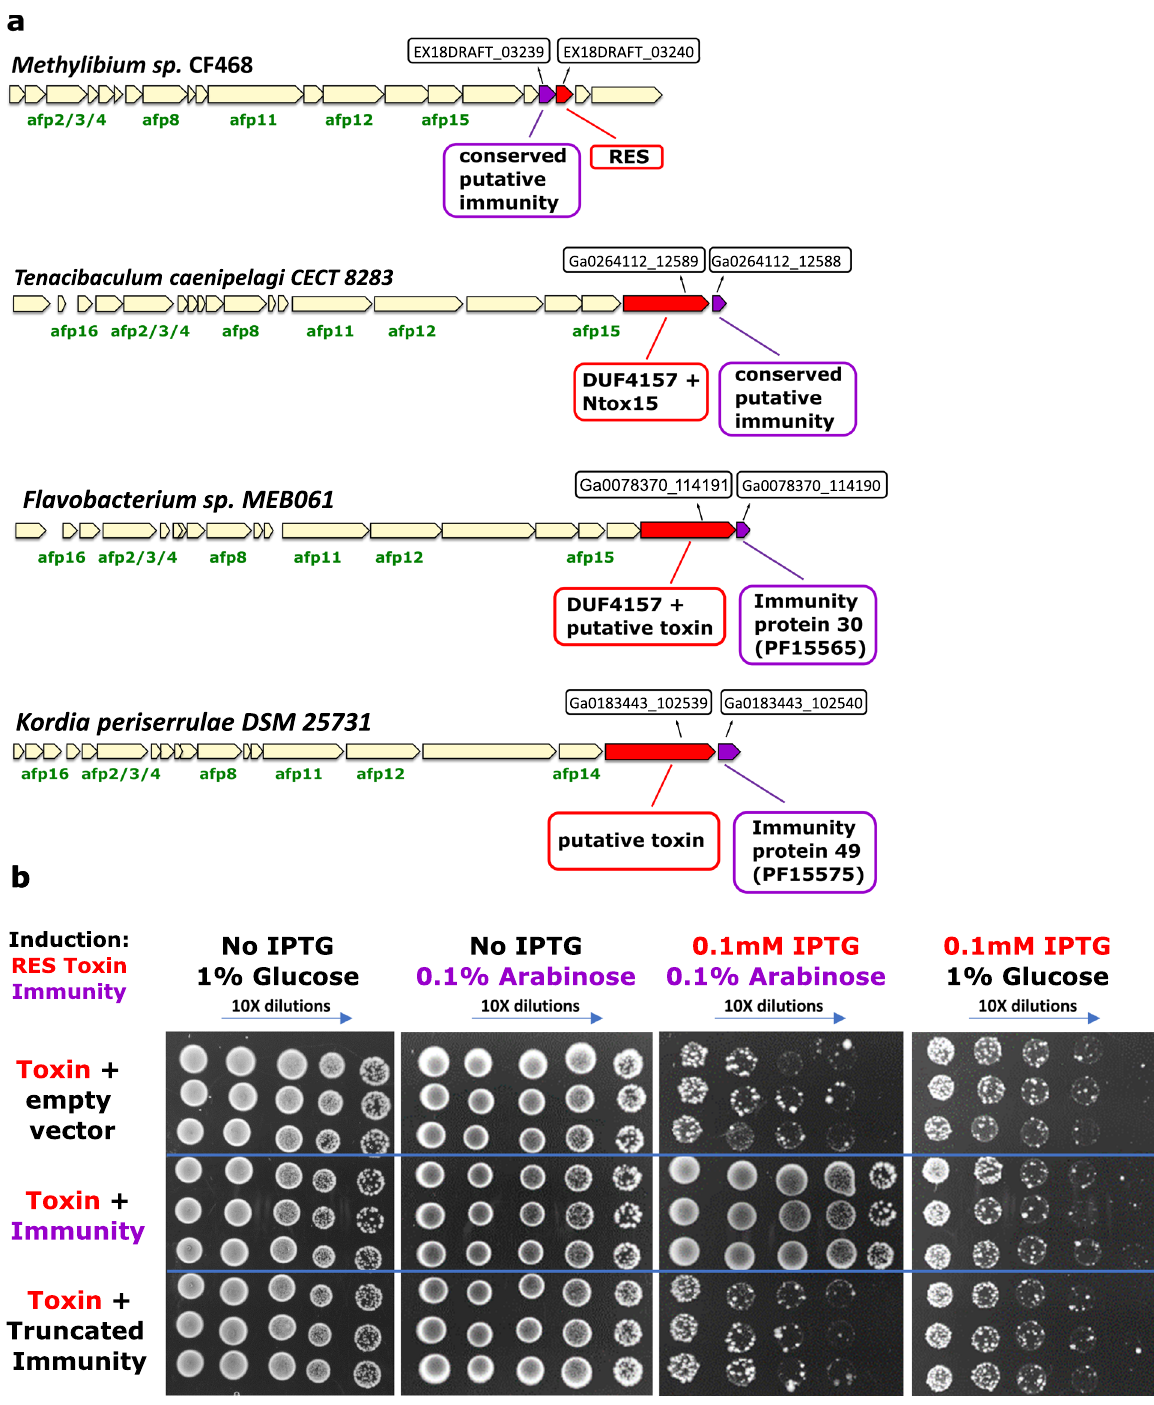
Fig. 5 Toxin-immunity gene pairs are genetically associated with eCIS. a Pairs of known antibacterial toxins found in eCIS. eCIS operons containing known or putative antibacterial toxin or immunity domains. b XRE-like antitoxin protects from RES-like toxin (EAT5). Induction by IPTG leads to expression of RES-like toxin (IMG locus tag EX18DRAFT_03240). Glucose represses XRE-like antitoxin (IMG locus tag EX18DRAFT_03239) or its truncated version while Arabinose induces expression of XRE-like antitoxin (or its truncated version). Each section (separated by blue lines) represents three biological